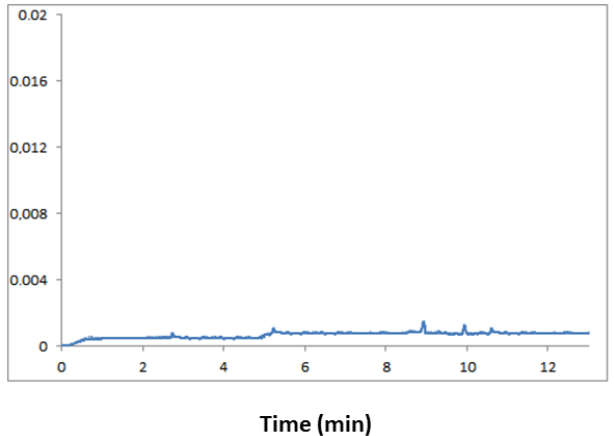
Figure 3. Representative electropherogram of a blank urine sample obtained after the SPE clean-up procedure. All separation conditions the same as in Figure 1.